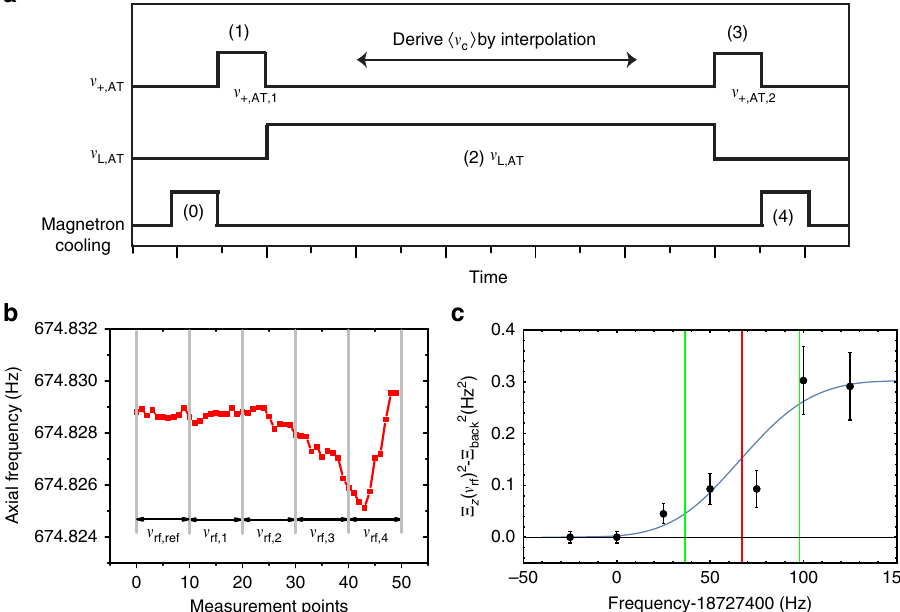
Figure 2 | Experiment sequence and measurement of the cyclotron frequency. ( a ) We first centre the particle in the trap by cooling the magnetron motion to E (cid:2) / k B o 4mK. Then we measure the modified cyclotron frequency n þ ,AT,1 . Subsequently we scan the Larmor resonance n L,AT and then measure the modified cyclotron frequency again n þ ,AT,2 . Afterwards we re-cool the magnetron motion. For a more detailed explanation of the experiment sequence we refer to the text. ( b ) Sequence of axial frequency measurements of 30s averaging time while a radial dipolar drive at n rf, k is applied. The drive frequency is adjusted after each 10 measurements. Once the drive excites cyclotron transitions n rf, k E n þ ,cut , the axial frequency fluctuation increases. ( c ) Projection of axial frequency data to axial frequency fluctuation X z ( n rf ). The error bars represent the standard deviations of the individual measurements. The red and green vertical lines indicate the determined mean value n þ ,cut and its 95% confidence level uncertainties, respectively, the blue solid line is a fit based on the the data-analysis described in the